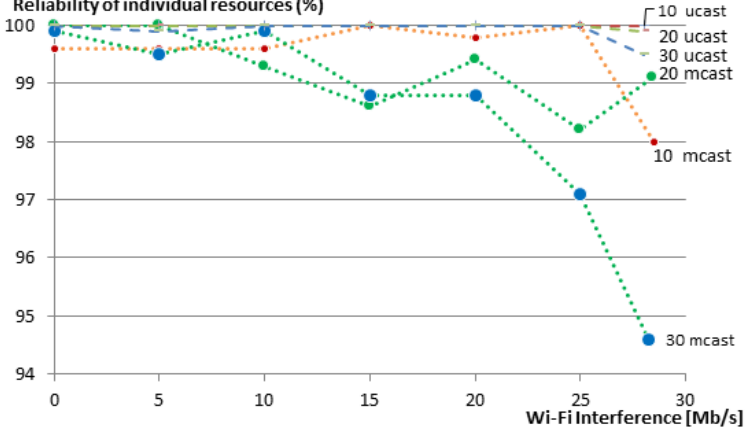
Figure 10. Member reliability for both unicast and multicast group communication and varying group sizes in the presence of Wi-Fi interference. The member reliability is much better when using unicast-based group